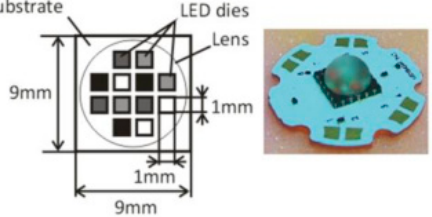
Figure 7. Schematic and photograph of the four wavelength LED (460, 530, 590, and 620 nm). Reproduced with permission from Ref. [27].